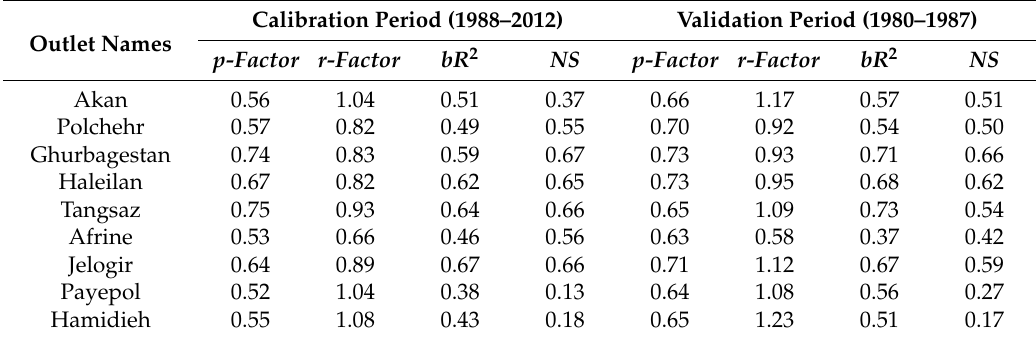
Table 3. Calibration and validatation performances of simulated discharge in SWAT. NS, Nash Sutcliffe.